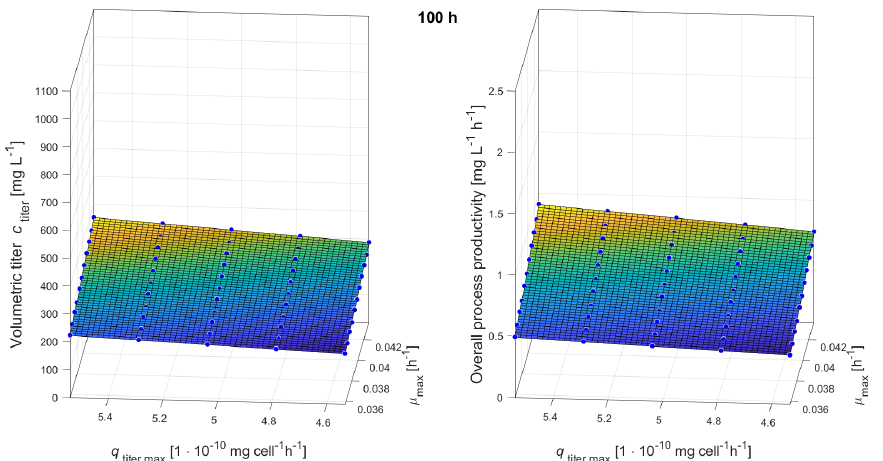
Figure A5. Response surfaces showing the impact of maximum growth rate and maximum production rate on volumetric titer and overall process productivity after 100 hours in production.